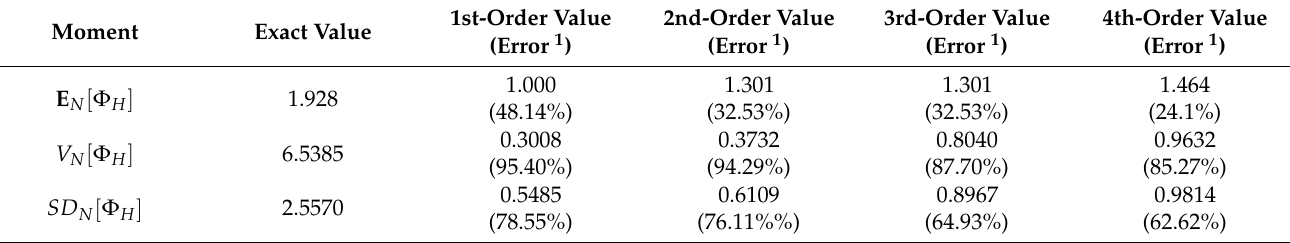
Table 3. Exact and approximate values for the expectation, variance and standard deviation of Φ H ( σ ; E ) for β = 0.95. Moment Exact